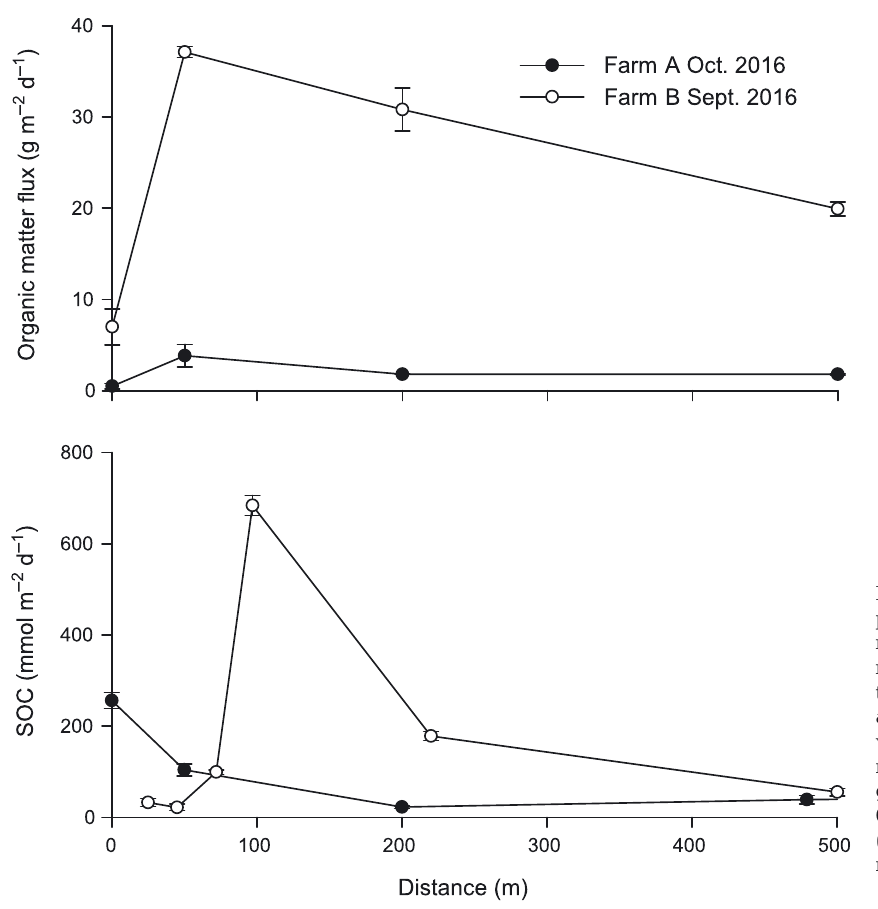
Fig. 9. Vertical fluxes (mean ± SE) of particulate organic matter and sedi- ment oxygen consumption (SOC) measured at different distances from the edge of Atlantic salmon net-pens at Farms A and B. Measurements were made in the predominant cur- rent direction from each farm. Or- ganic matter flux rates shown for the 0 m distance are from Law & Hill (2019) and were measured simulta- neously with those shown at greater